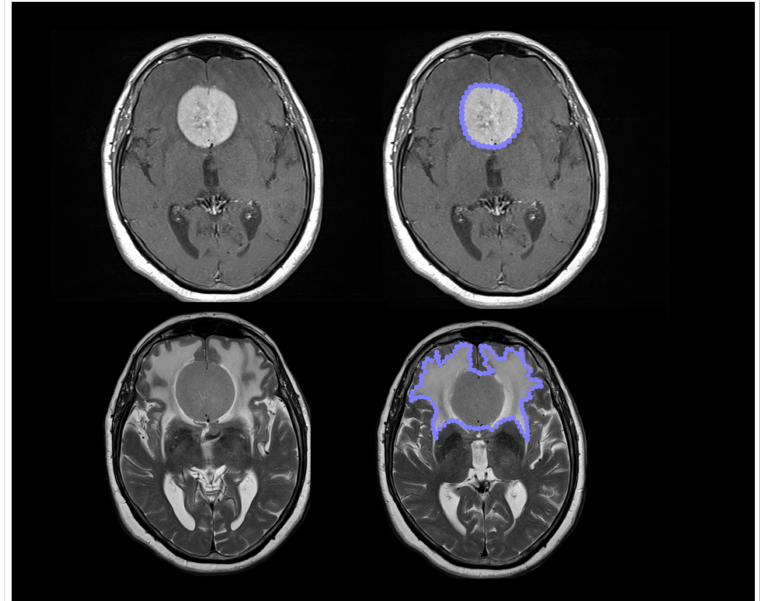
Figure 1. Using Horos software, we measured the volume of the meningioma using a semi-automatic pencil tool outlining the contrast-enhanced lesion on 3D T1-weighted sequences and its relative hyperintense signal T2-weighted